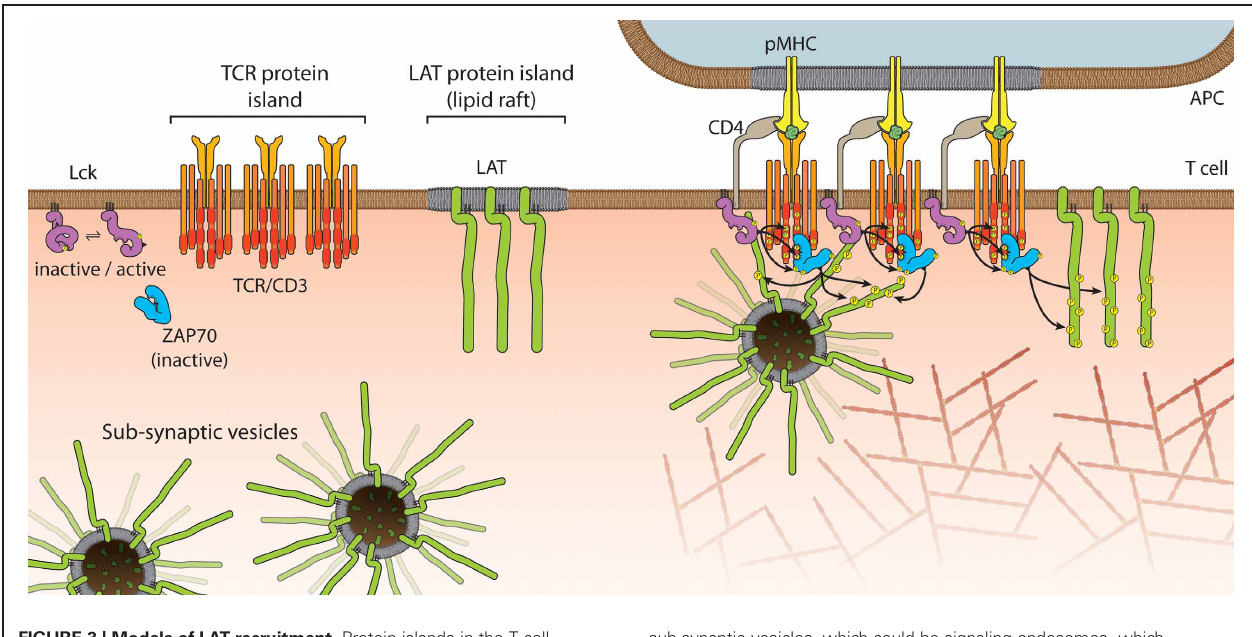
FIGURE 3 | Models of LAT recruitment. Protein islands in the T cell membrane can aggregate or coalesce during TCR activation to facilitate phosphorylation and signal transduction. An alternative model invokes